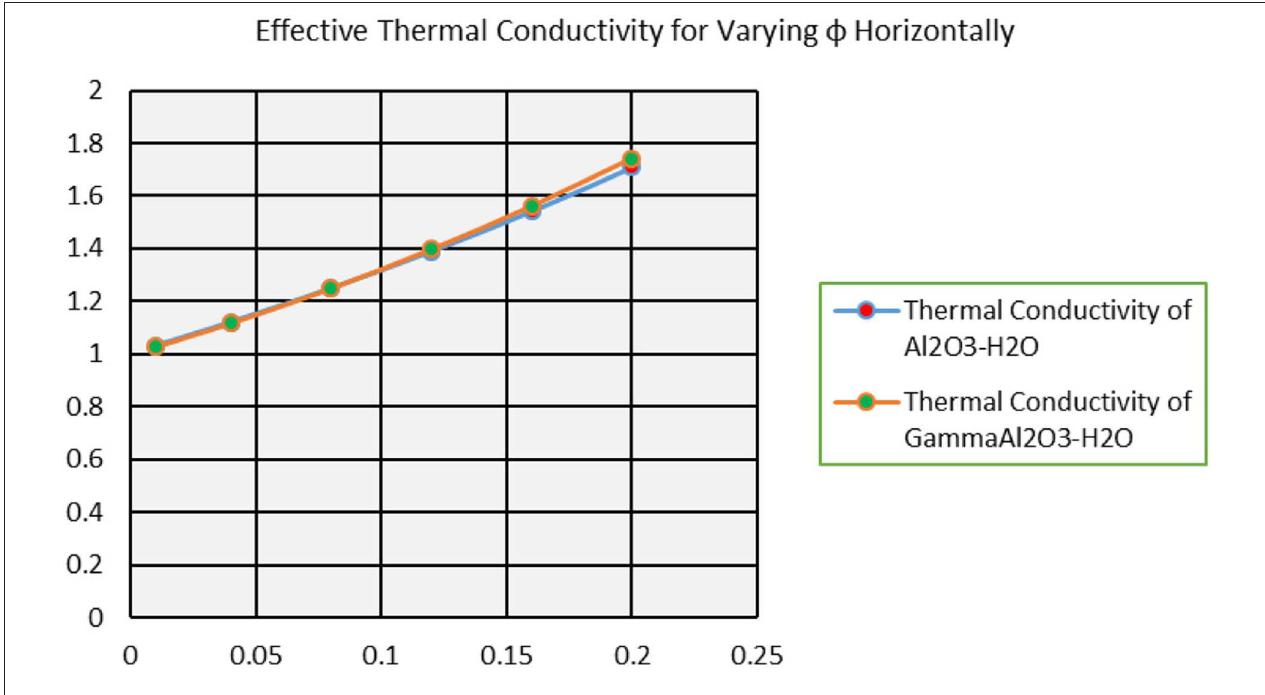
FIGURE 17 | The effects of φ on Thermal conductivity.